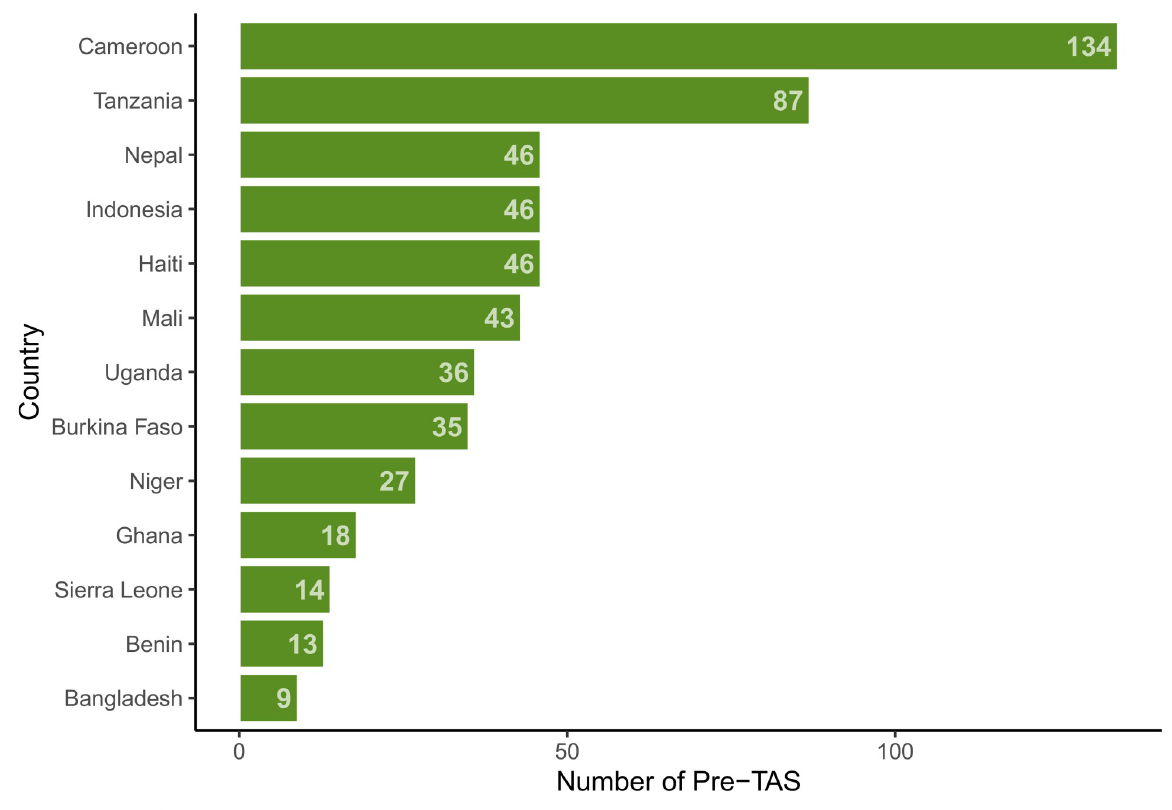
Fig 1. Number of pre-TAS by country.